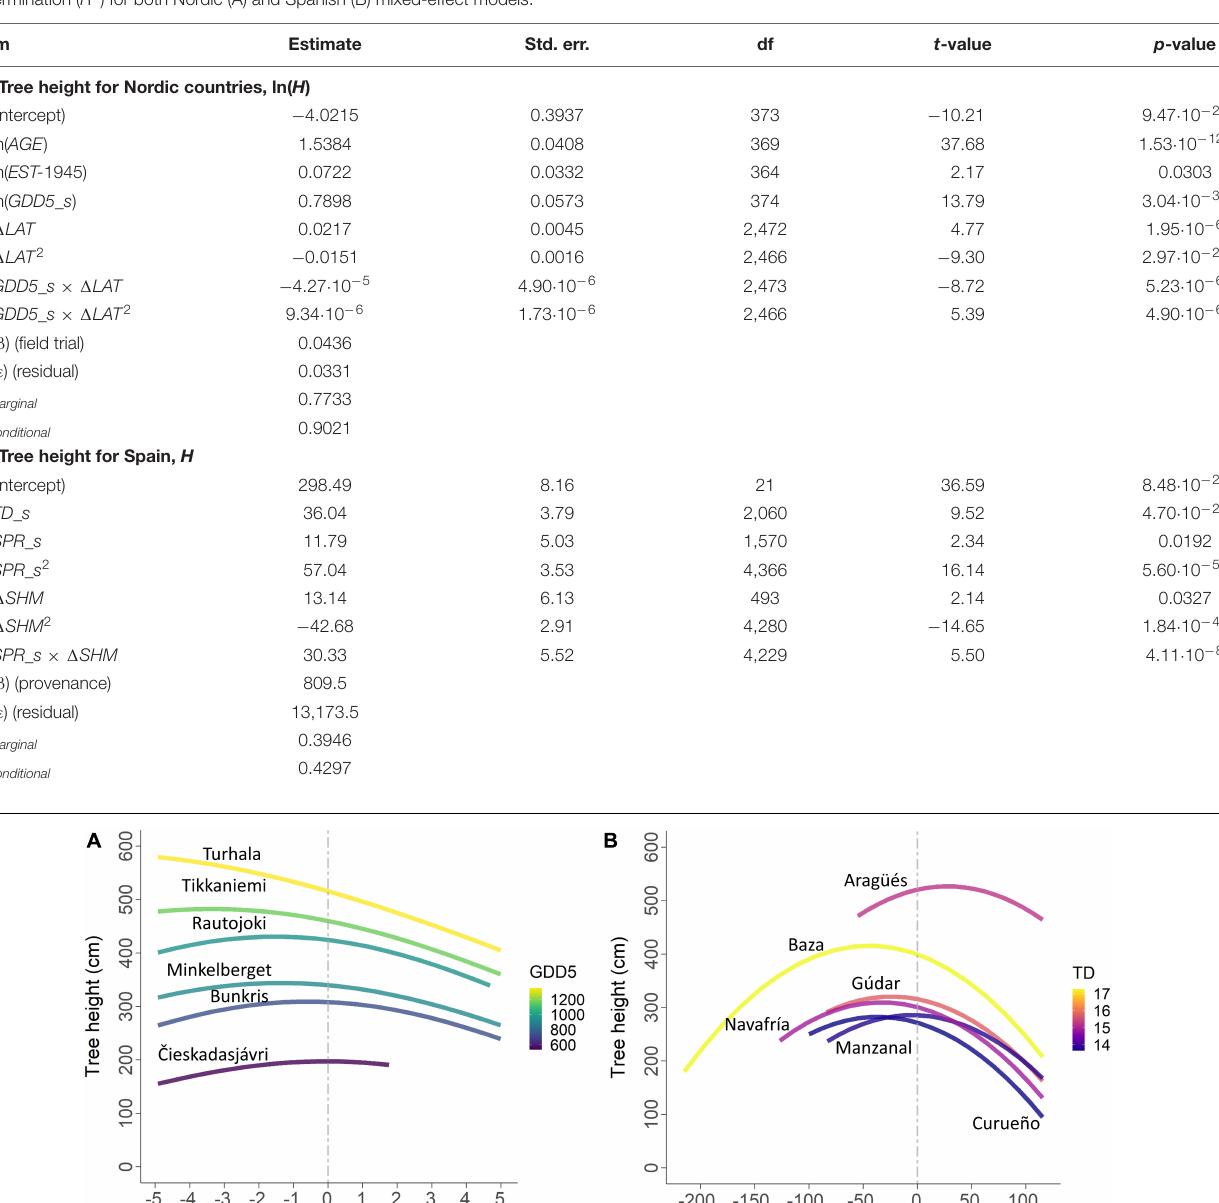
TABLE 3 | Regression coefficients (estimate and standard errors), significance tests, variance component estimates [Var( x )] plus marginal and conditional coefficients of determination ( R 2 ) for both Nordic (A) and Spanish (B) mixed-effect models. Term Estimate Std. err. df t -value p -value